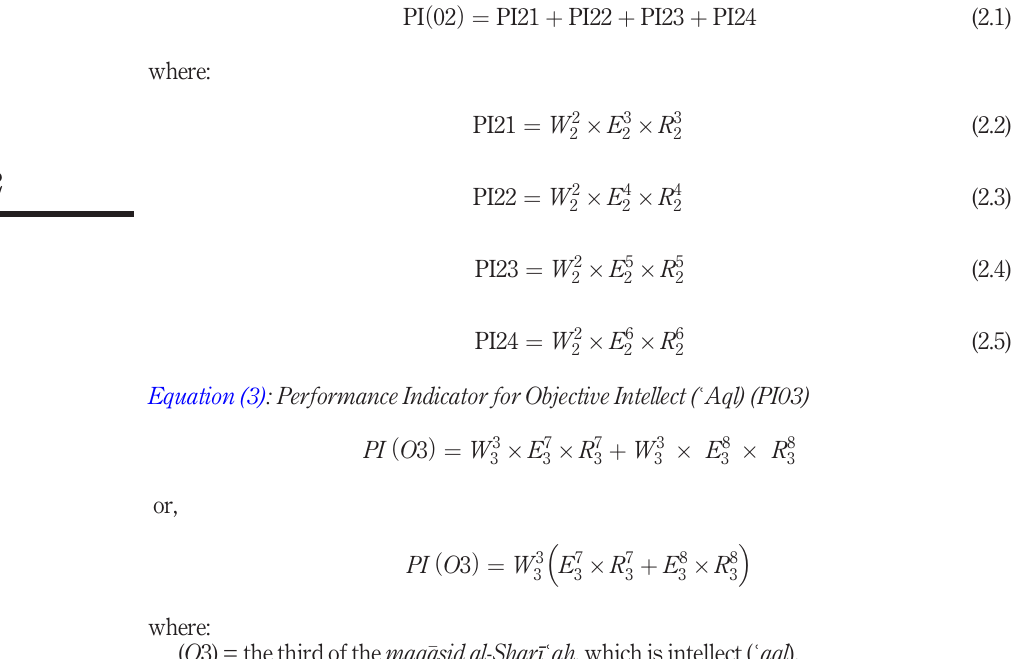
R 8 = the evaluation for the performance ratio corresponding to E 8 3